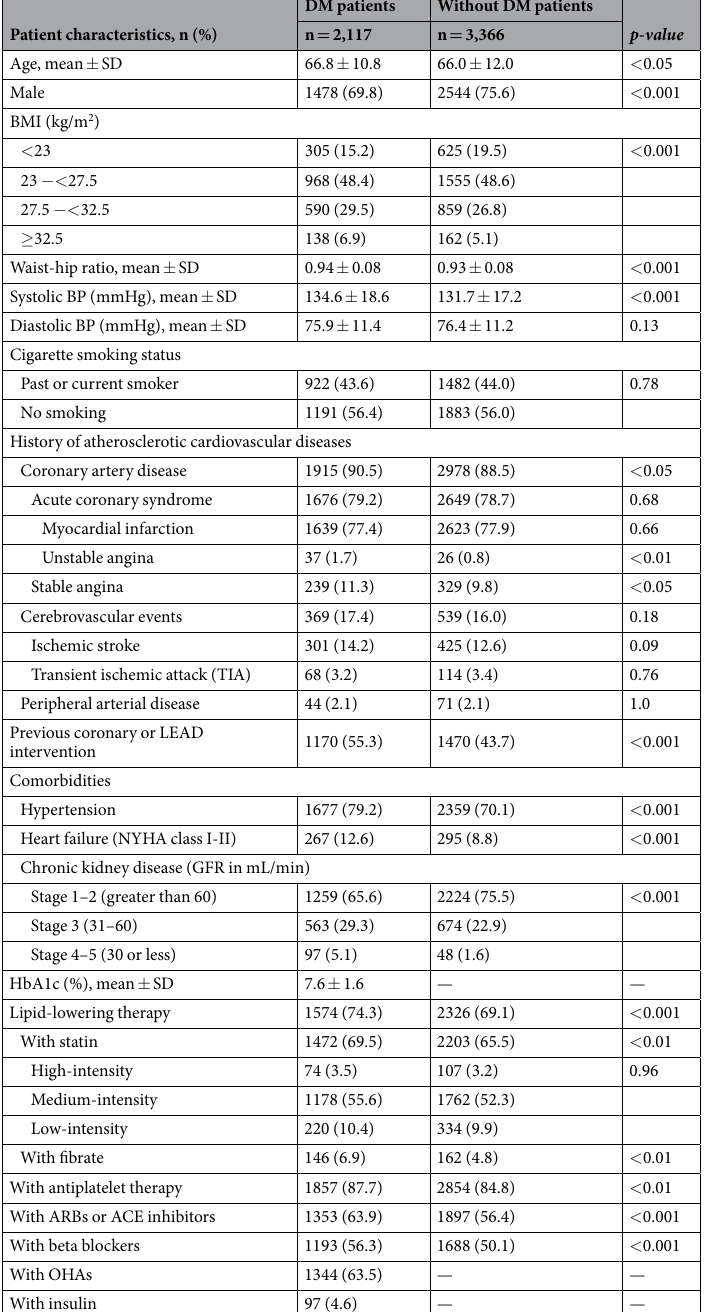
Table 1. Characteristics of the enrolled diabetic and nondiabetic patients. ACE = angiotensin-converting enzyme; ARB = angiotensin II receptor blocker; BP = blood pressure; GFR = glomerular filtration rate; LEAD = lower extremity arterial disease; NYHA = New York Heart Association; OHA = oral hypoglycemic